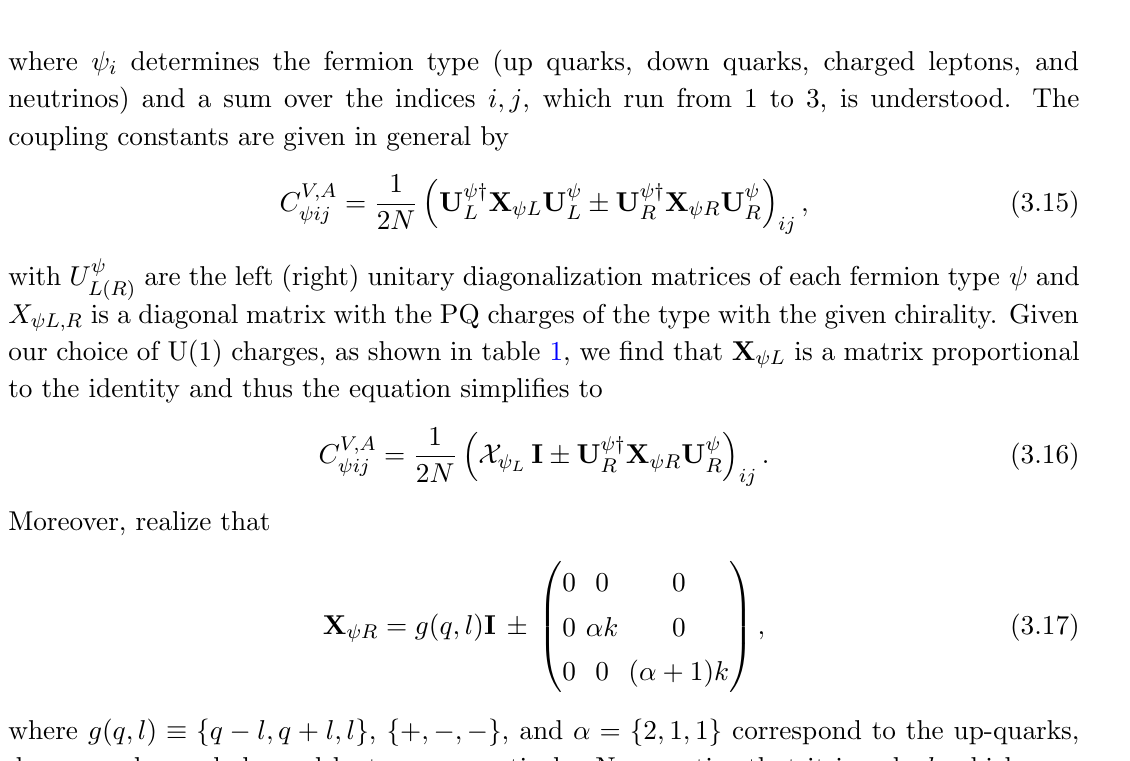
Figure 3 . Axion exclusion plot from [77] with the derived E=N = 8 = 3 of this model. Shown is the axion-photon coupling versus the axion mass. The colored areas are excluded regions while transparent colored regions will be tested by future experiments [22, 22{26, 76, 78{90]. Also shown in grey the mass region for